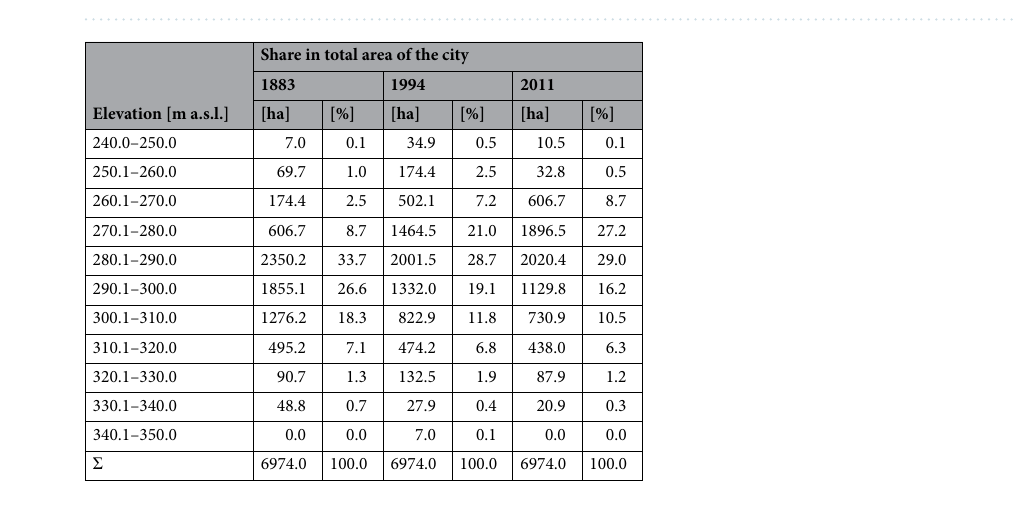
Table 1. Differences in elevation within the Bytom city area in the years